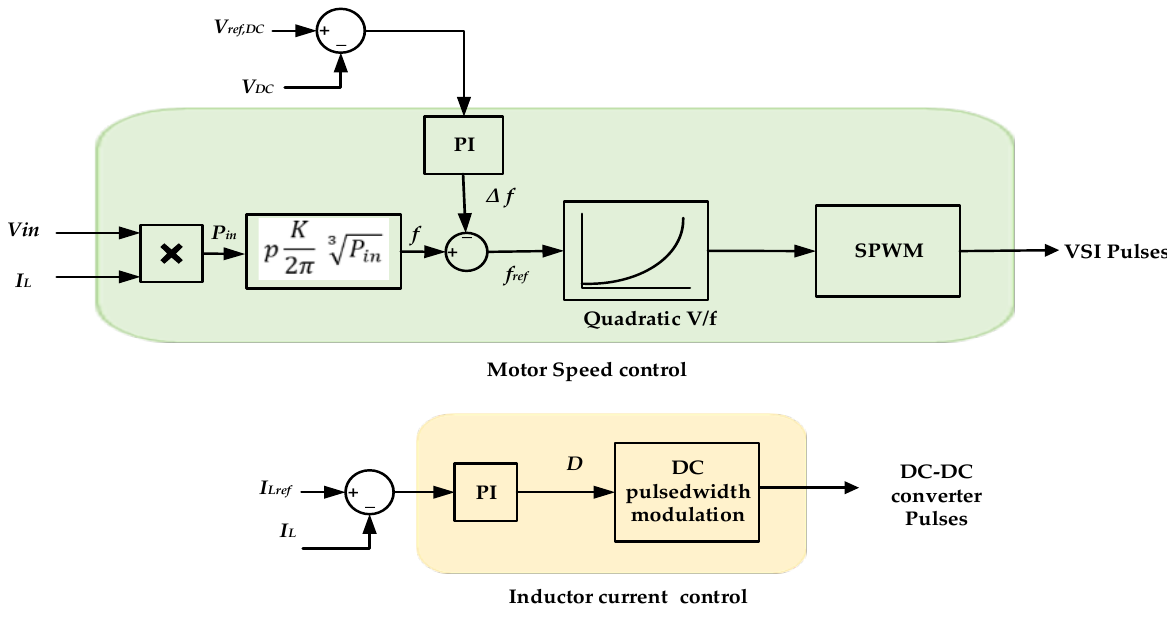
Figure 3. The proposed control of the two-stage direct-coupled solar PV water pumping system.